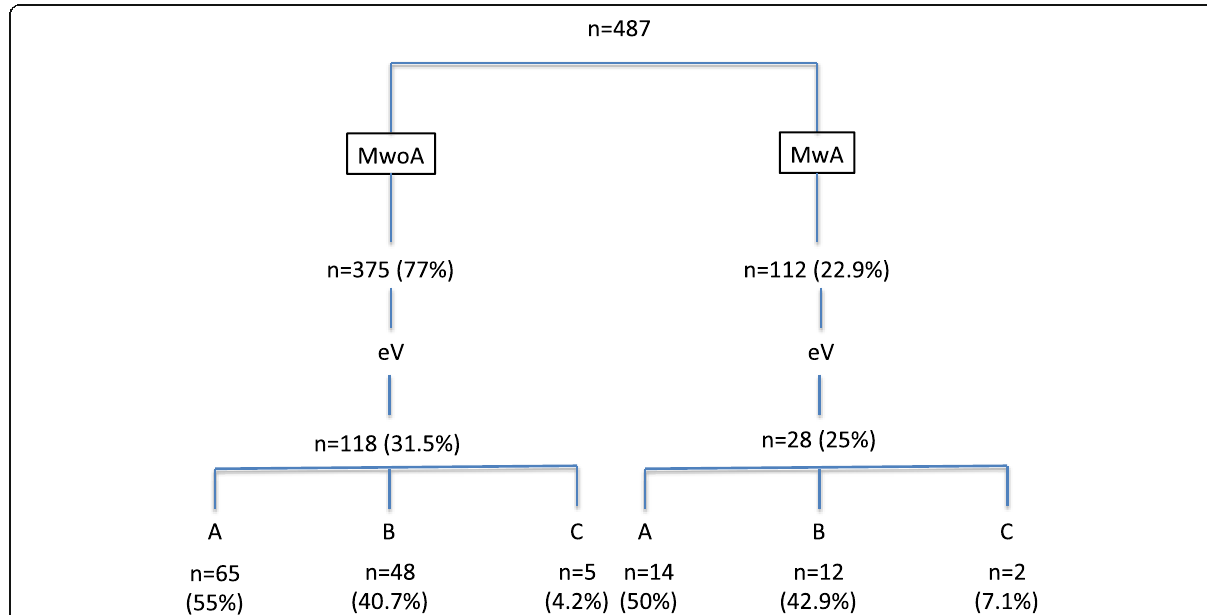
Fig. 1 Flowchart of patients enrolled in the study with a breakdown into migraine subtypes and the composition of the 3 classes in each